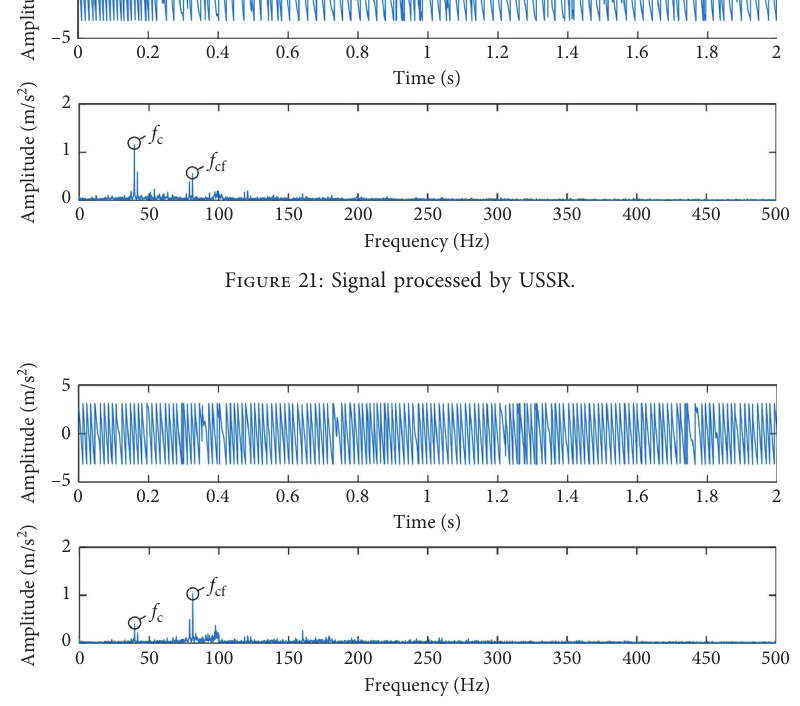
Figure 22: Signals processed by USAGVSR.